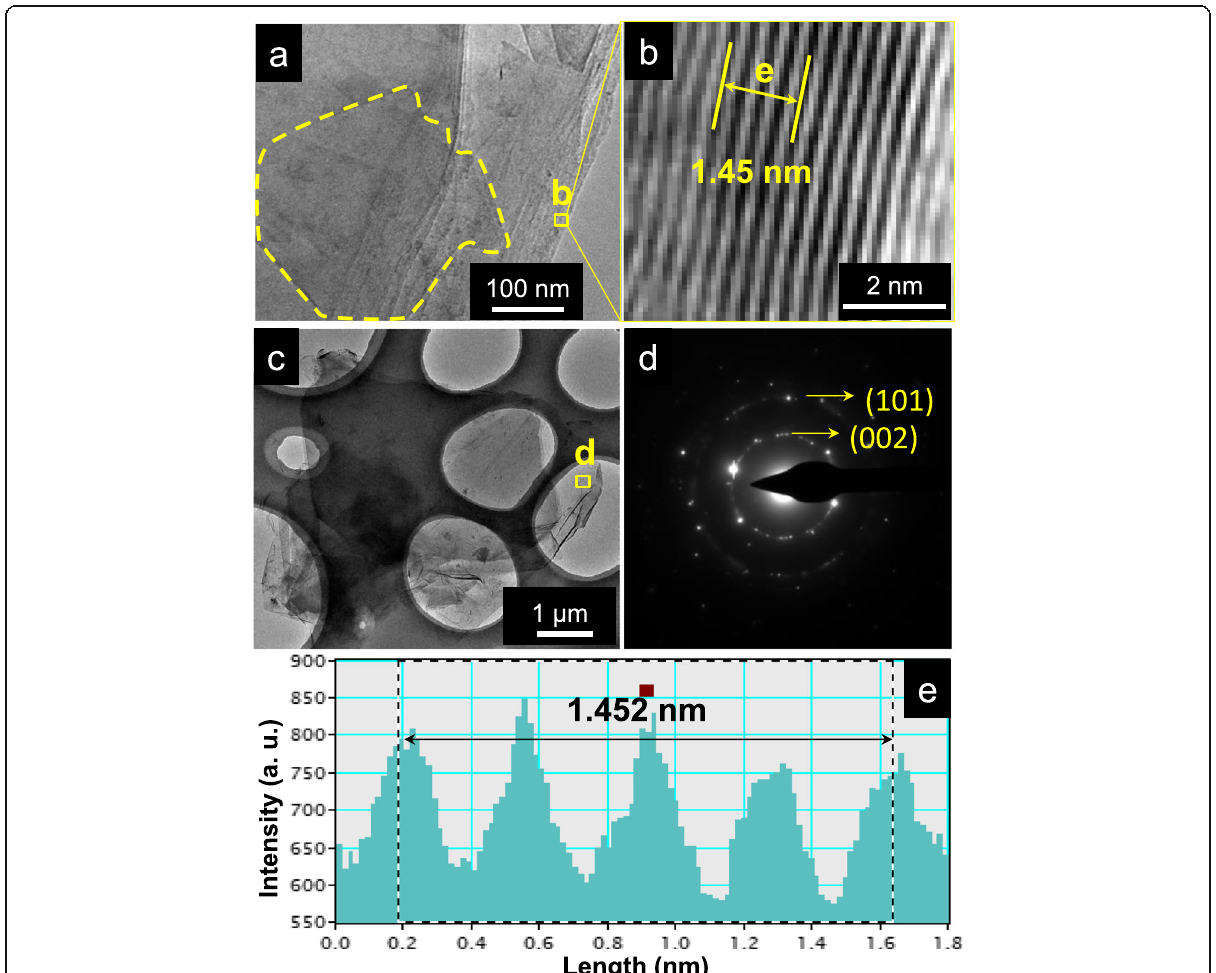
Fig. 5 The TEM analysis of SA-GO (which is prepared by the reactions of octadecylamine and the sulfur-doped graphene oxide; the oxidation time of the graphene oxide is 24 h). Including the stacked SA-GO ( a ), the high-resolution TEM image of the square zone marked in a ( b ), the dispersed SA-GO ( c ), the SAED diffraction pattern of the square zone marked in c ( d ), and the crystalline space analysis of the position marked